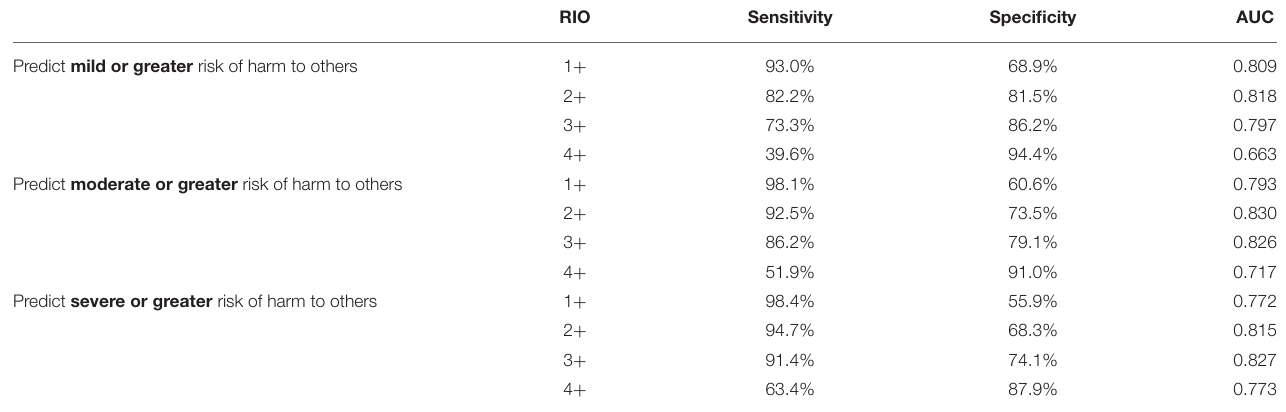
TABLE 5 | Sensitivity and specificity results for the derivation sample: mild, moderate, and severe.